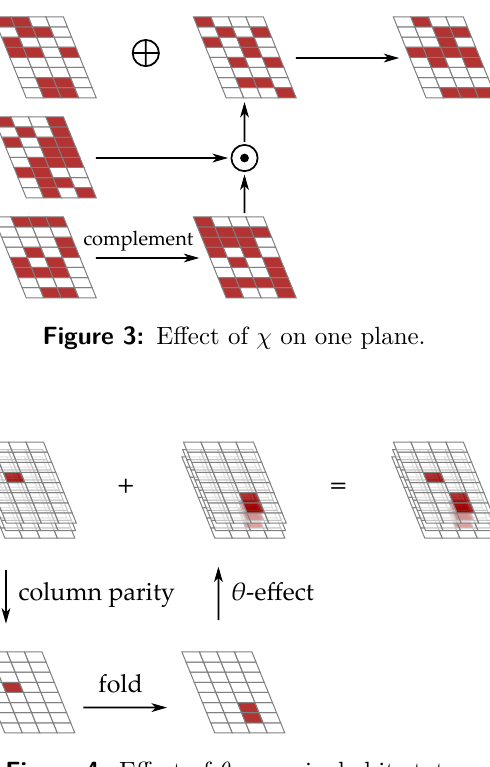
Figure 4: Effect of θ on a single-bit state.